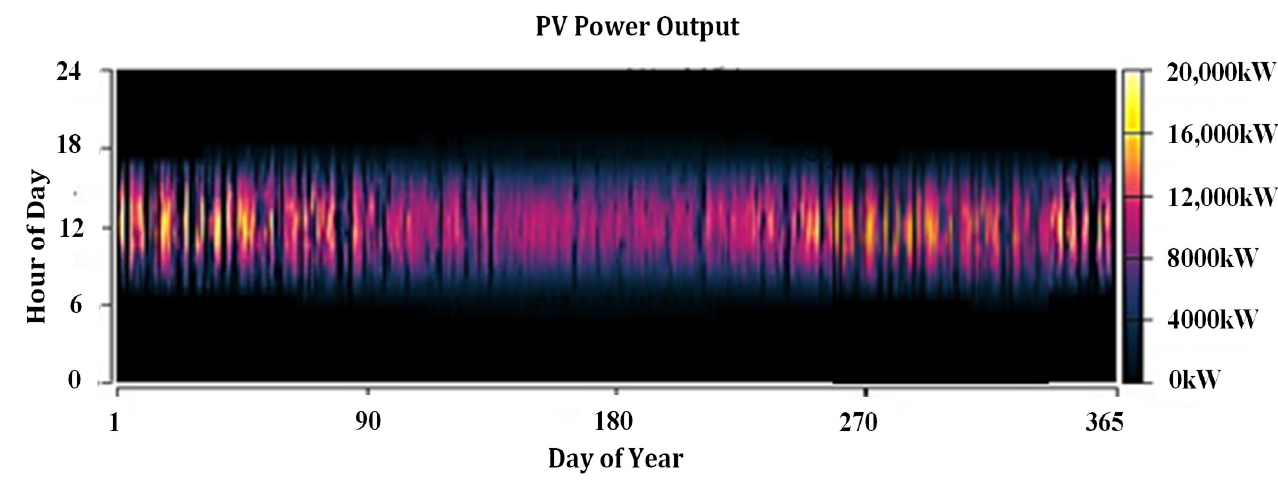
Figure 22. Annual PV generator operation.